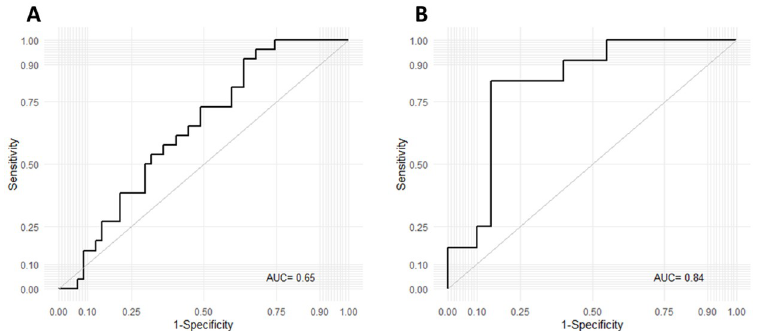
Fig 3. ROC curve analysis assessing whole blood expression of eca-miR-127 for discrimination of ES affected (RGR + PGR) from ES-free horses (NO + CTL) at the time of initial examination for the entire population (A) and solely within FM horses (B). Abbreviations: ROC = Receiver Operating Characteristic. AUC = Area Under the Curve, RGR = regression, PGR = progression, NO = new occurrence, CTL = control, FM = Franches-Montagnes